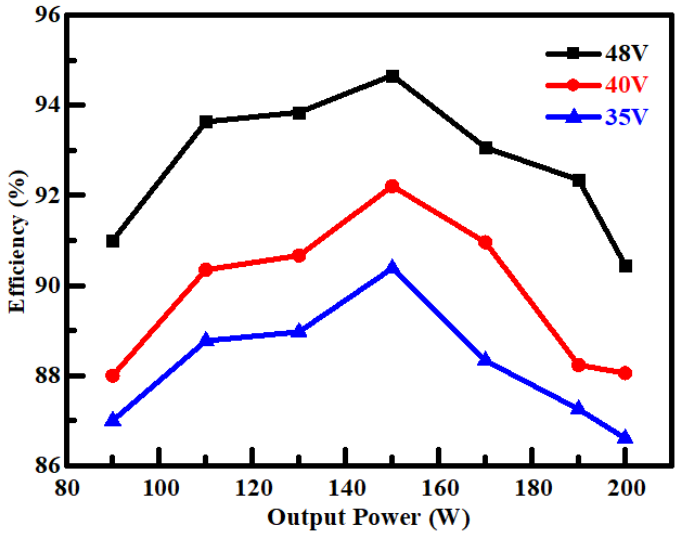
Figure 25. Experimentally measured efficiency plot with the variation of output load power with fixed 400 V output Voltage.